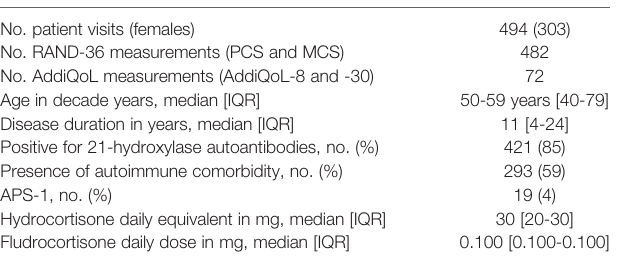
TABLE 1 | Patient